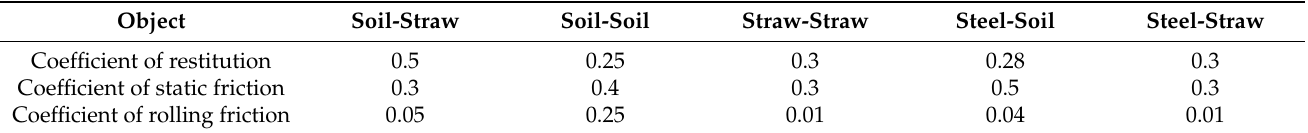
Table 2. Basic contact parameters among different materials.